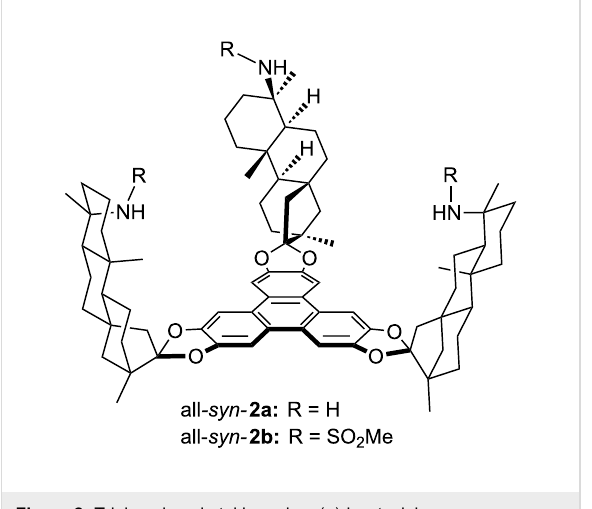
Figure 2: Triphenylene ketal based on ( − )-isosteviol.